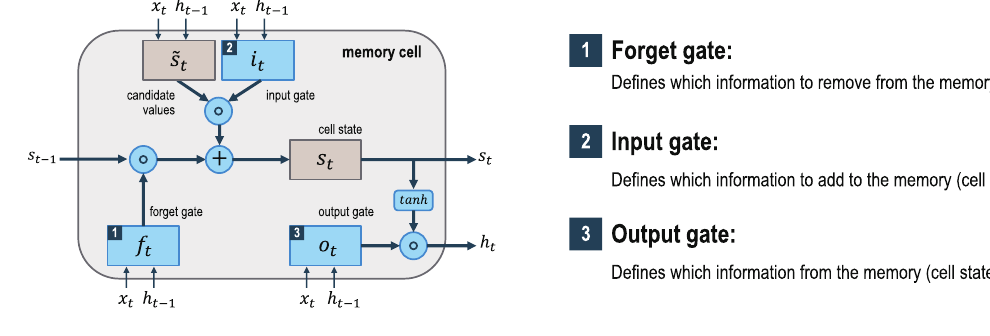
Figure 3. The architecture of LSTM memory block